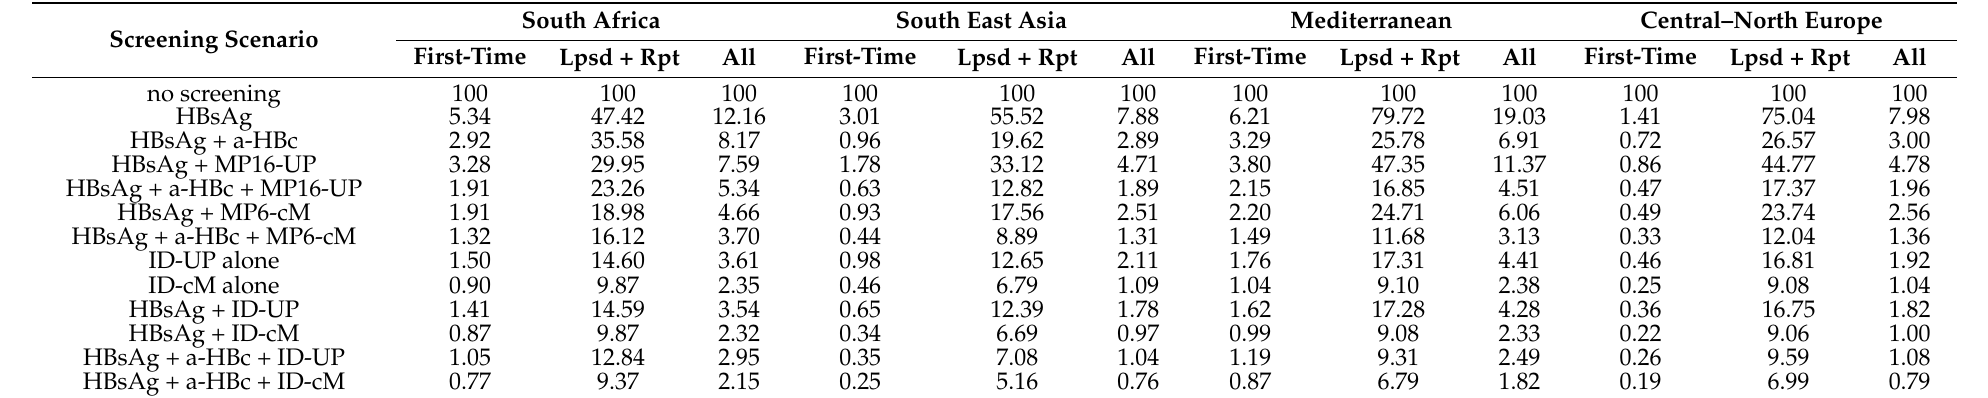
Table 3. Residual HBV transmission risk for different screening options and donation categories as calculated from yield rates in four geographical regions